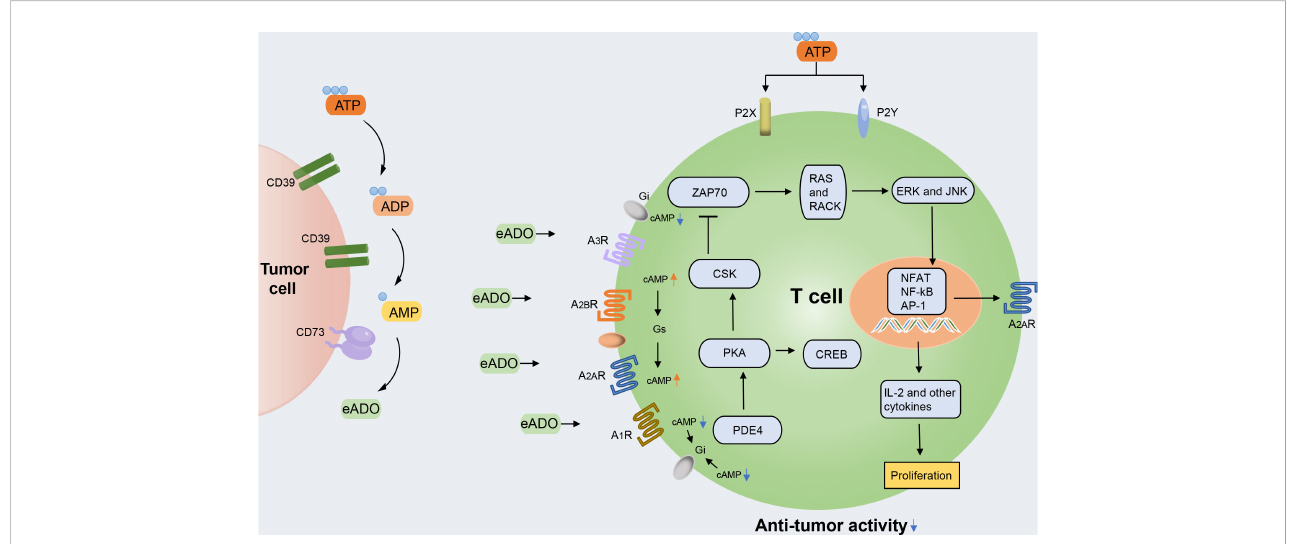
FIGURE 1 The ATP-adenosine pathway regulates immune response in the tumor microenvironment (TME). The accumulated extracellular ATP (eATP) can activate immune cell in fl ammation activity by stimulating type 2 purinergic receptors (P2XR and P2YR). The accumulated extracellular ADO (eADO) can bind to the downstream purinergic receptors (A 1 R, A 2A R, A 2B R, and A 3 R), resulting in the accumulation of cAMP. cAMP accumulation leads to protein kinase A (PKA) phosphorylation and the activation of C-terminal Src kinase (CSK), which reduces downstream LCK-dependent activation of ZAP70, extracellular signal-regulated kinase 1 (ERK1), and JNK and protein kinase C (PKC). PKA activation also activates cAMP-responsive element-binding protein 1 (CREB), which contributes to the inhibition of the major pro-in fl ammatory transcription factor nuclear factor- k B (NF- k B). Through this intracellular signaling pathway, the TCR-mediated activation of immune cells is